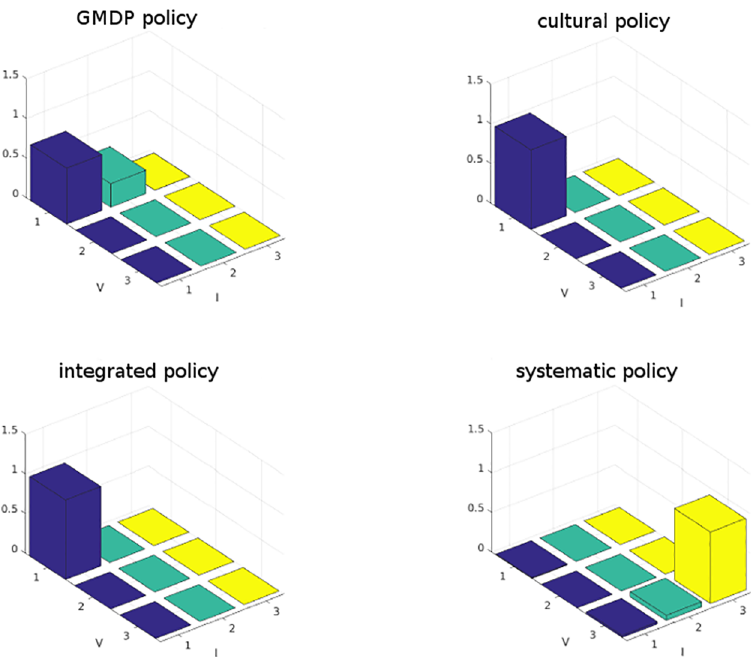
Fig 6. Distribution of wheat field states, in averageover 100 simulations of 100 yearsof blackleg dynamics. Axis I indicatesthe level of inoculumproduction in the field (1 = low, 2 = medium, 3 = high), and axis V indicatesthe percentageof virulent spores in the inoculum(1 = low, 2 = medium, 3 = high).